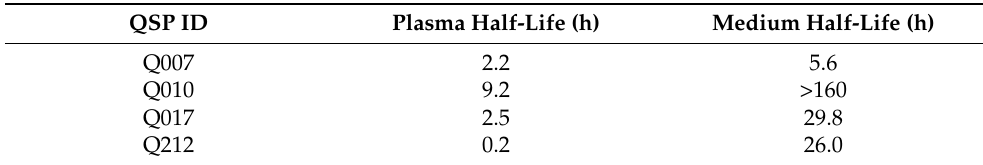
Table 2. Plasma and cell medium half-life values of four QSPs.